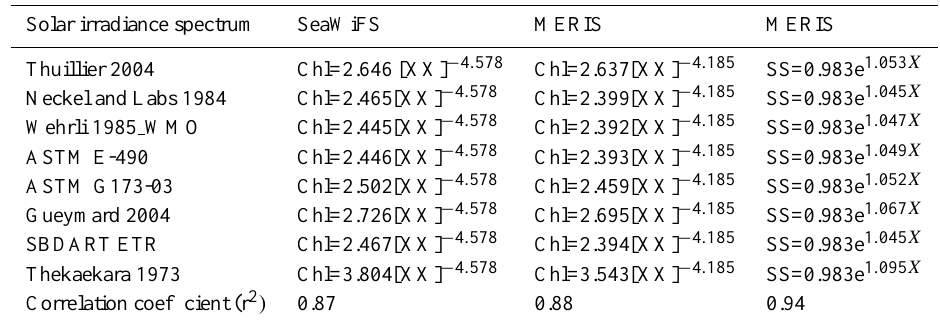
Figs. 9a and b. Scatter plots of the SeaWiFS_Others [nLw(490)/nLw(555)] and MERIS_Others [nLw(490)/nLw(560)] versus SeaWiFS_Thuillier 2004 [nLw(490)/nLw(555)] and MERIS_Thuillier 2004 [nLw(490)/nLw(560)]. Others are the ratios from the Neckel and Labs 1984, Wehrli 1985_WMO, ASTM E-490, ASTM G173-03, Gueymard 2004, SBDART ETR and Thekaekara 1973. (c and d) Log- log plots of the SeaWiFS [nLw(490)/nLw(555)] and MERIS [nLw(490)/nLw(560)] as a function of the in-situ Chl concentrations. The total number of observations, N = 338. Note that once again the Thekaekara 1973 proves to be different with the others. Table 6. The retrieval algorithms of chlorophyll and suspended sediment predicted for SeaWiFS and MERIS for the different solar irradiance